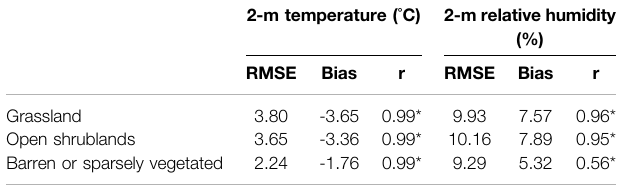
Frontiers in Earth Science |